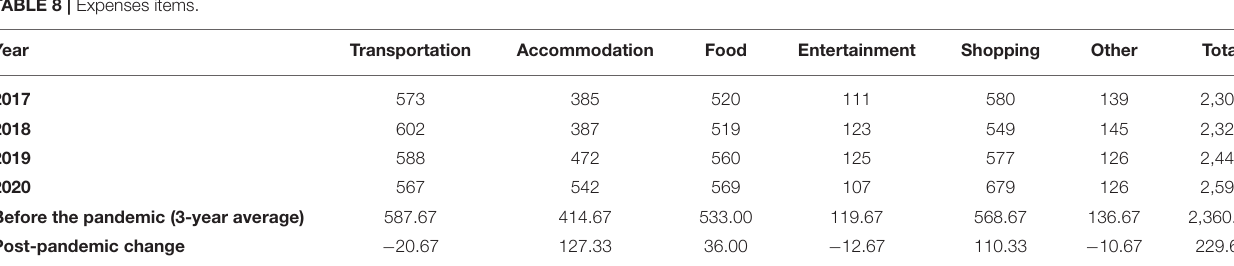
TABLE 8 | Expenses